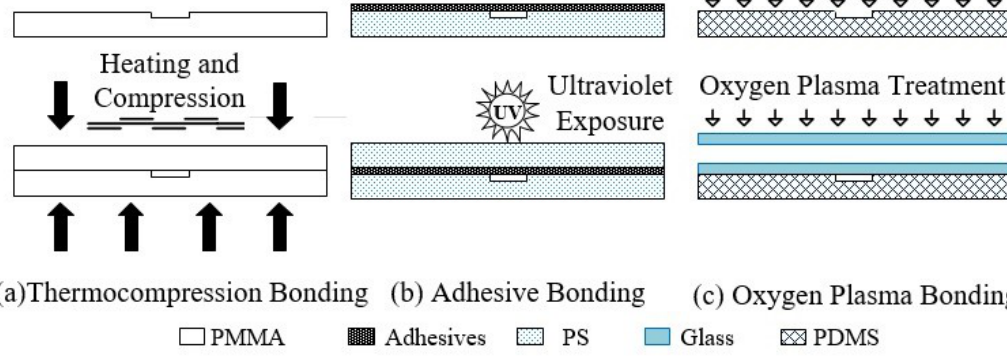
Figure 4. Common microfluidic chip bonding methods.